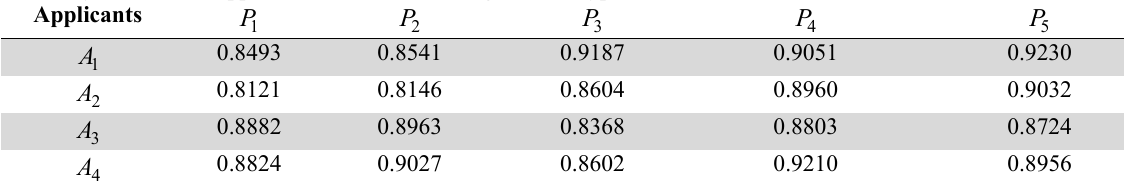
Similarity measure of Applicants vs. Positions using (4) and Type-3 score function